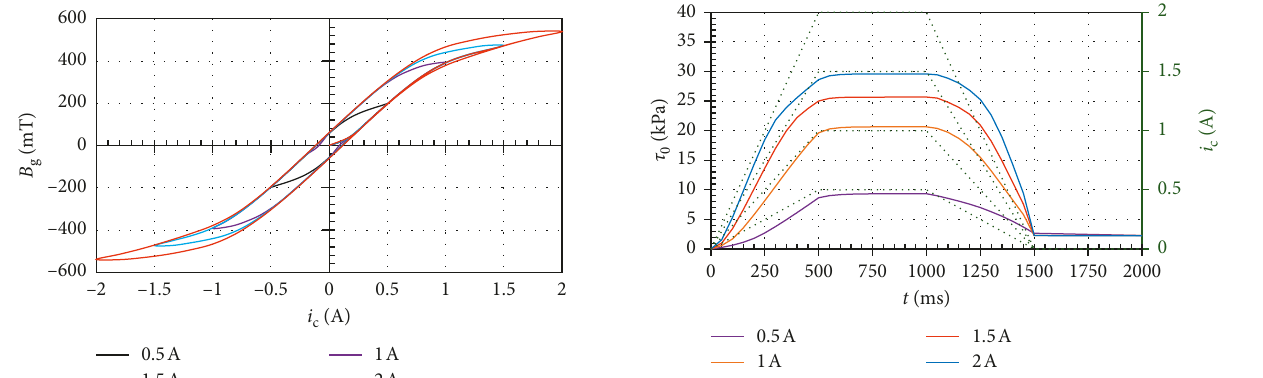
Figure 16: Time history: yield stress (full line) and electric current (dotted green